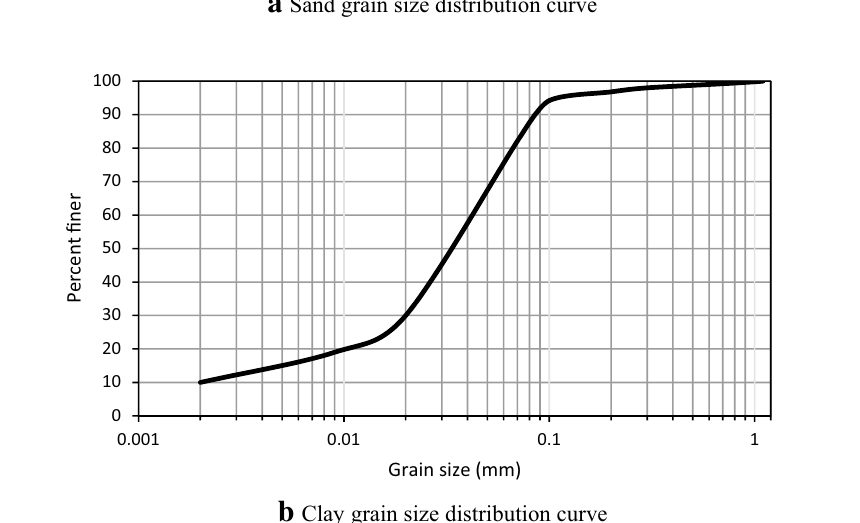
Fig. 1 Grain size distribution curves for soils